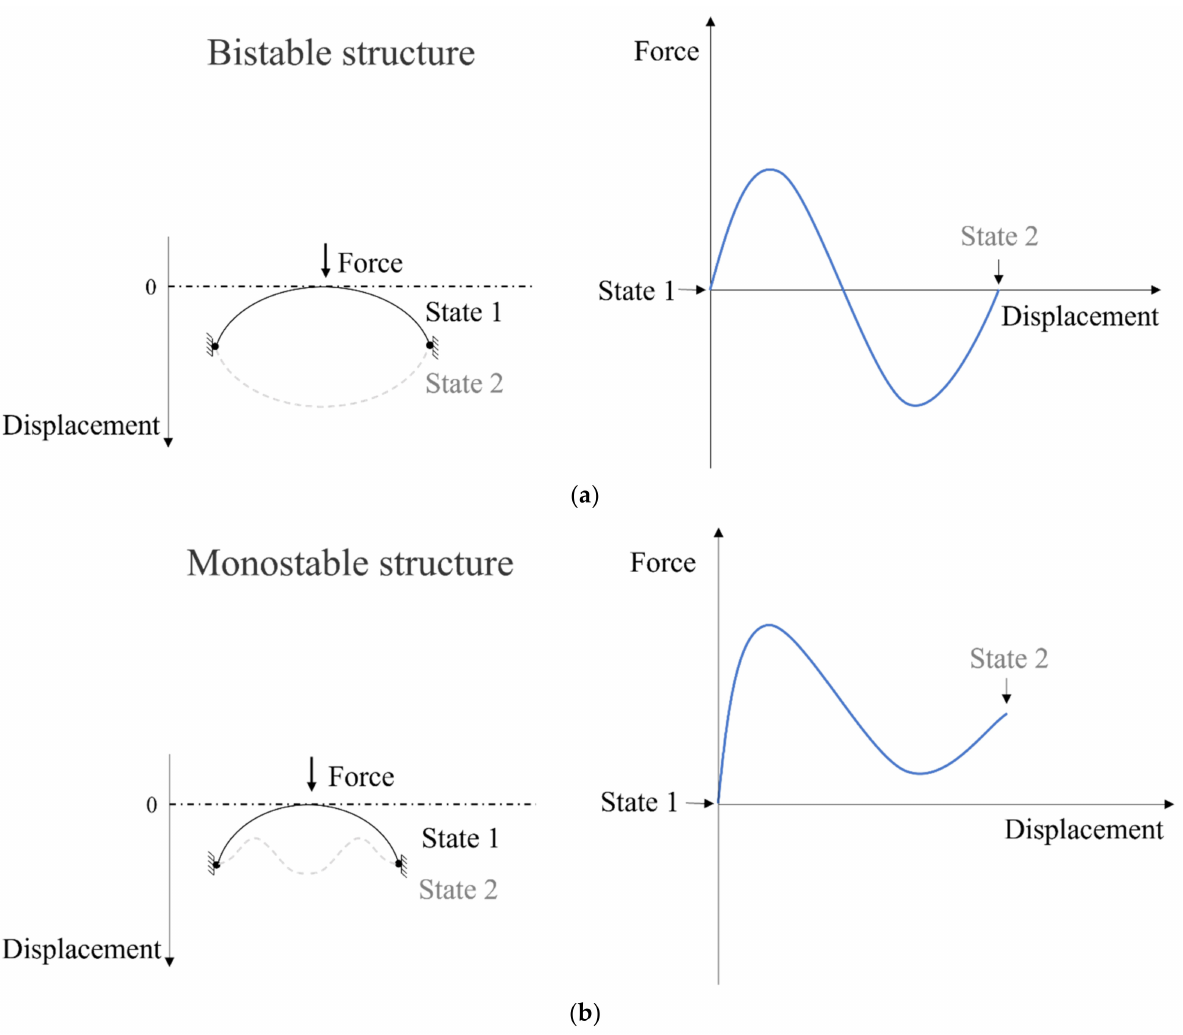
Figure 6. A sketch of ( a ) the bi-stable NBS and ( b ) the monostable structure is presented on the left-hand side, while the corresponding mechanical characteristics are shown on the right-hand side,